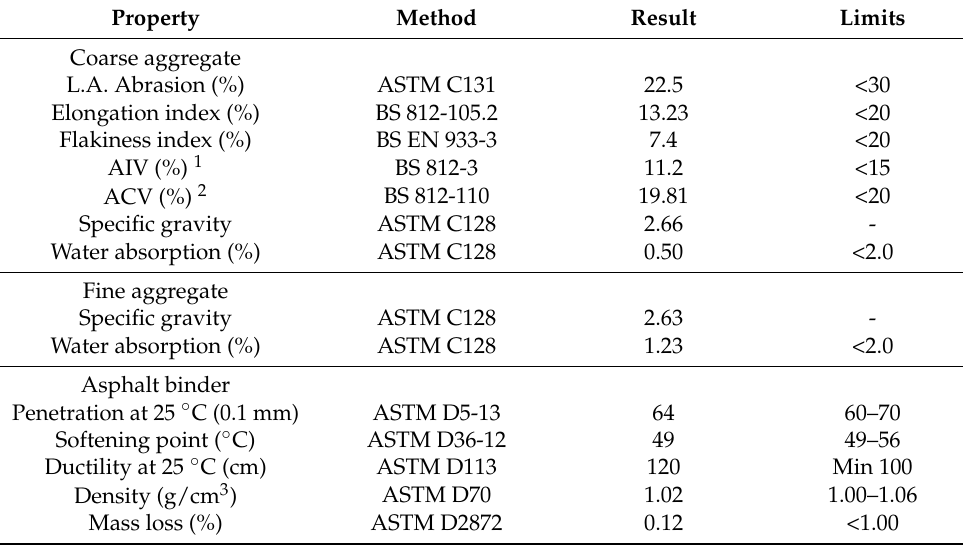
Table 1. Physicochemical properties of aggregate and asphalt